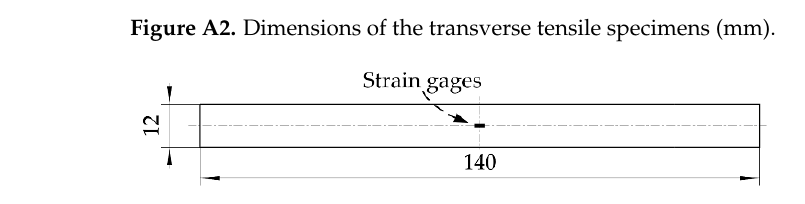
Figure A3. Dimensions of the unidirectional compressive specimens (mm).